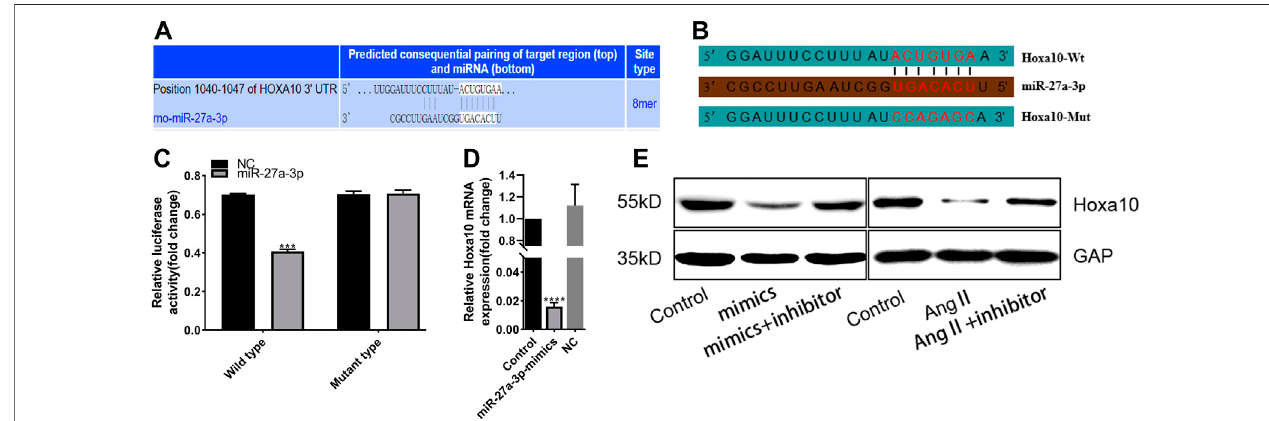
FIGURE 5 | MiR-27a-3p can negatively regulate the expression of Hoxa10. (A) The binding sequence of miR-27a-3p and 3 ′ UTR region of Hoxa10 was predicted by TargetScan. (B) Wt 3 ′ UTR and Mut 3 ′ UTR of Hxoa10 were constructed. (C) Luciferase assay con fi rmed that miR-27a-3p had transcriptional regulation effect on Hoxa10 . (D) The expression of Hoxa10 was decreased in miR-27a-3p-mimics treatment group compared with the control and NC group. (E) Western blot was applied to detect the protein expression of Hoxa10 after treatment with miR-27a-3p-mimics and miR-27a-3p-inhibitor, as well as the Ang II and Ang II + miR-27a-3p inhibitor treatment. All the values are the mean of three independent experiments ( n (cid:2) 3). **** p < 0.0001, *** p < 0.001 vs.